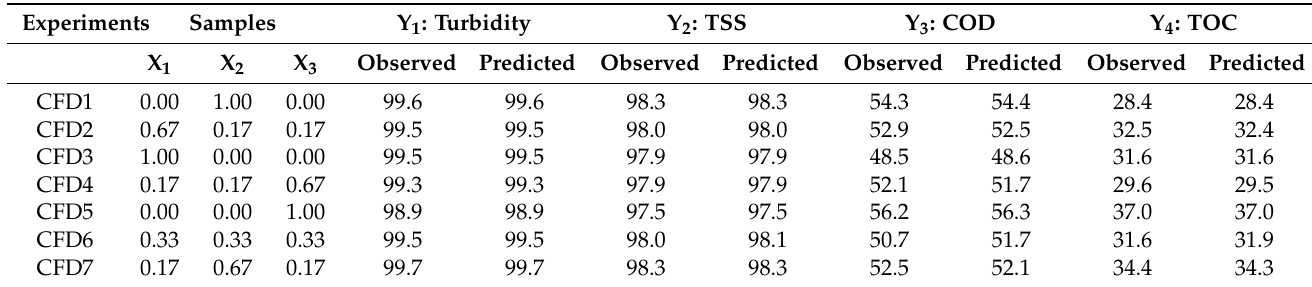
Table 5. Design matrix with the experimental and predicted removal percentages of turbidity, TSS, COD and TOC. Experimental conditions: pH 4, temperature 298 K, rapid mix 150 rpm/3 min, slow mix 20 rpm/20 min, sedimentation time 12 h. X 1 —potassium caseinate, X 2 —bentonite, X 3 —PVPP.